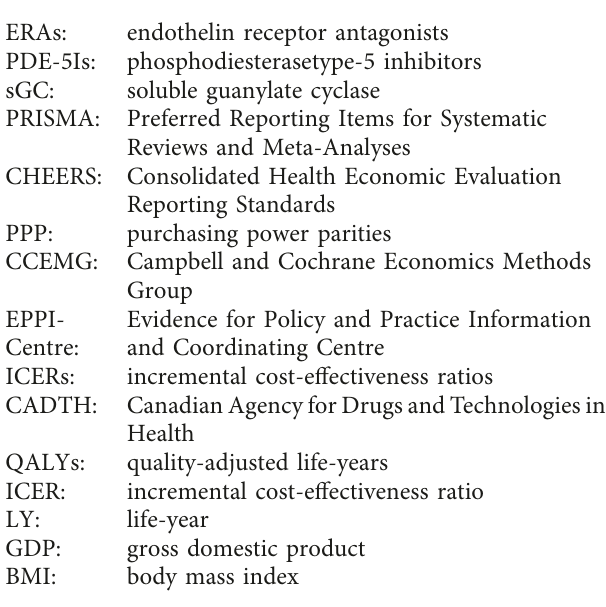
Table S1: literature search algorithm. (